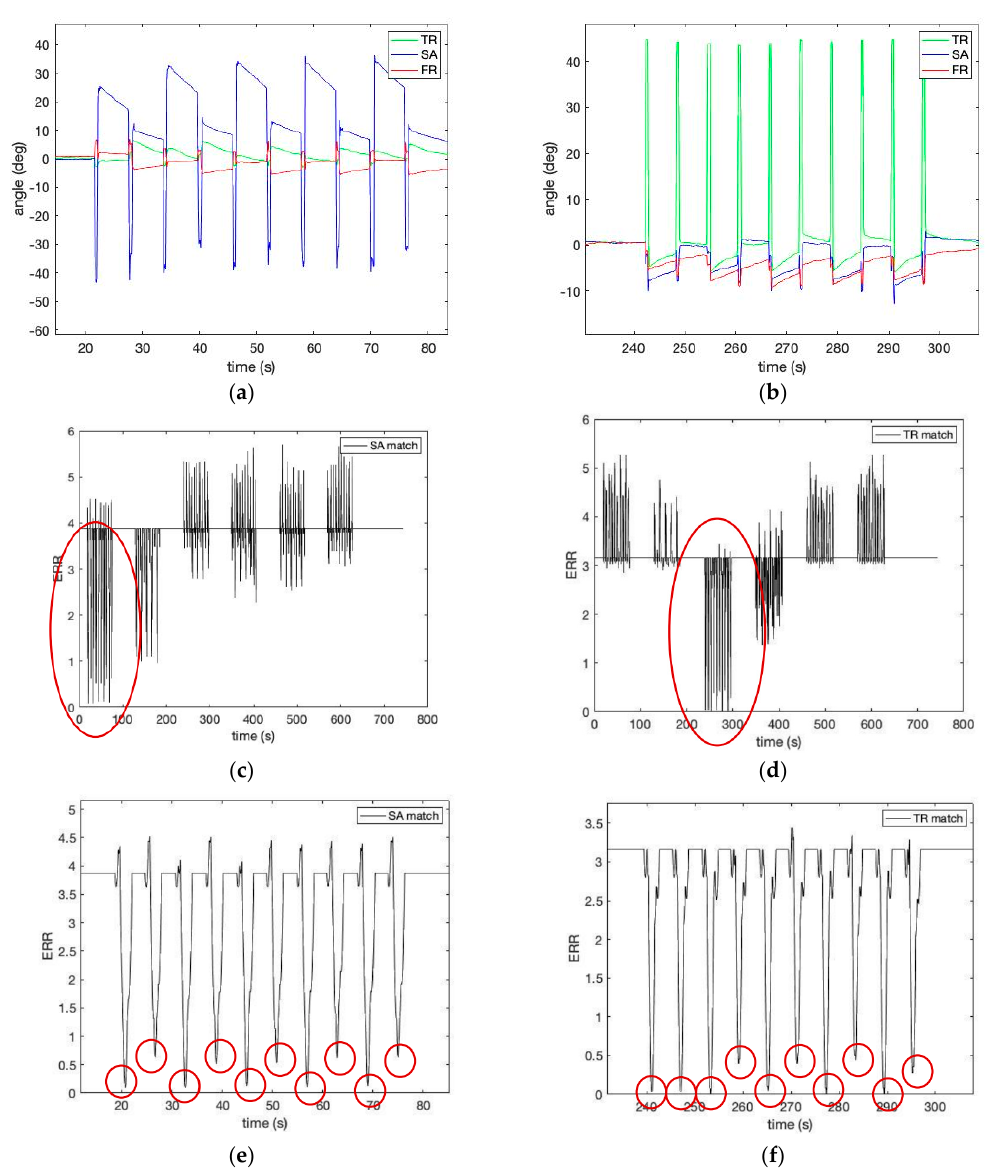
Figure 6. The estimated robot simulator motion pattern: ( a ) the measured angles for Experiment I—sagittal forward flexion 60 ◦ ; ( b ) the measured angles for Experiment II—transverse right rotation 50 ◦ ; ( c ) the matching error level from Experiments I, II, and III calculated by the template matrix of sagittal forward flexion 60 ◦ ; ( d ) the matching error level from Experiments I, II, and III calculated by the template matrix of transverse right rotation 50 ◦ ; ( e ) the matching error level from Experiment I calculated by the template matrix of sagittal forward flexion 60 ◦ . Red circles demonstrate low matching error.; ( f ) the matching error level from Experiment I calculated by the template matrix of transverse right rotation 50 ◦ . Red circles demonstrate low matching